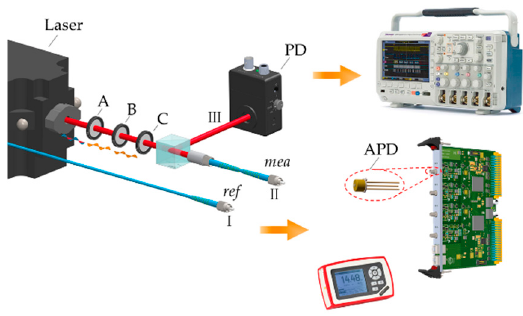
Figure 5. Optical configuration for equivalent tests of intensity drift error.